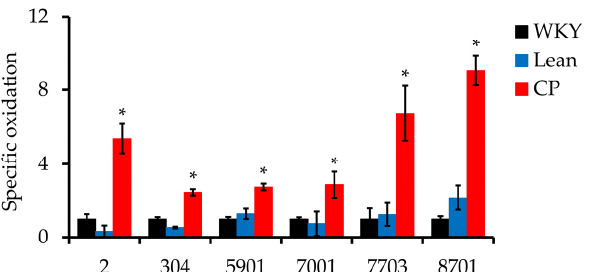
Figure 4. Specific oxidation of the six carbonylated protein spots of epididymal adipose tissues of 25-week-old CP. Specific oxidation was calculated from the relative carbonyl level (obtained from 2D-Oxyblot) per relative protein expression (obtained from 2D-DIGE). Data are mean relative car- bonyl protein levels ± SEM of four rats per group. * p < 0.05 compared with WKY and Lean. Table 5. List of proteins with increased carbonyl modi fi cation in epididymal adipose tissues of 25- week-old CP compared with WKY and Lean. Protein Name